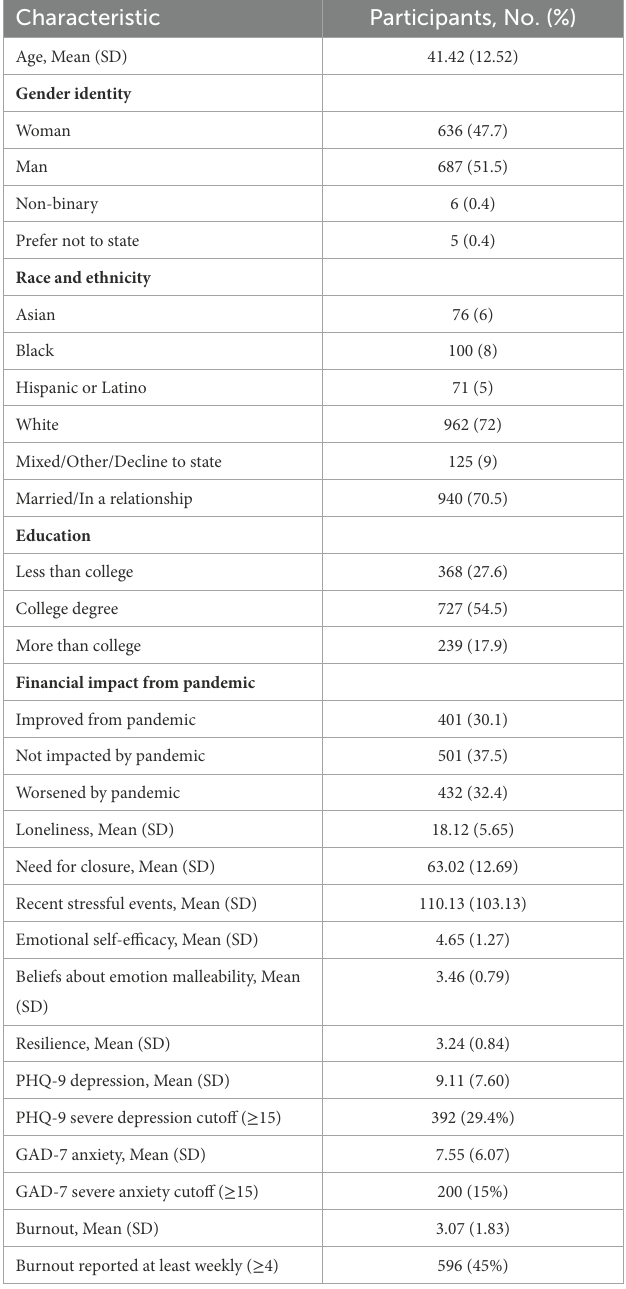
TABLE 1 Participant characteristics ( N =